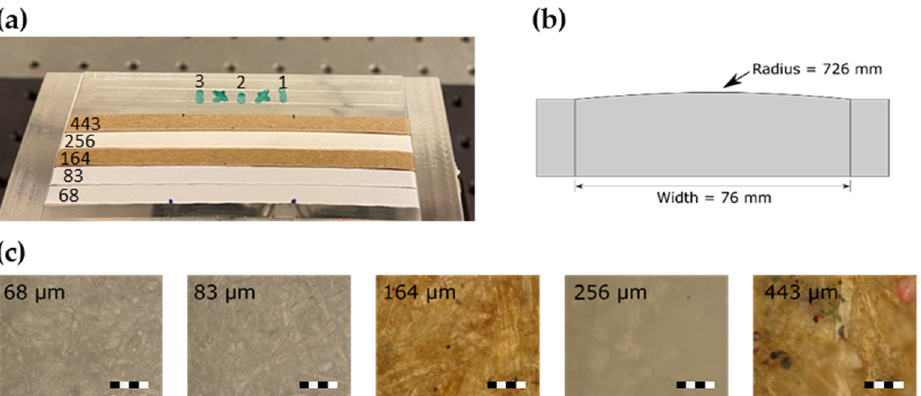
Figure 3. Paper samples. ( a ) Photograph of the sample holder with paper samples attached. The numbers 1, 2, and 3 indicate the lines along which measurements were taken and averaged. ( b ) Sketch of the arched sample holder, designed to stretch the paper and allow for better physical contact between paper and metal. ( c ) Optical microscope images of five paper samples at 20× magnification. Scale bars are 100 μ m long.